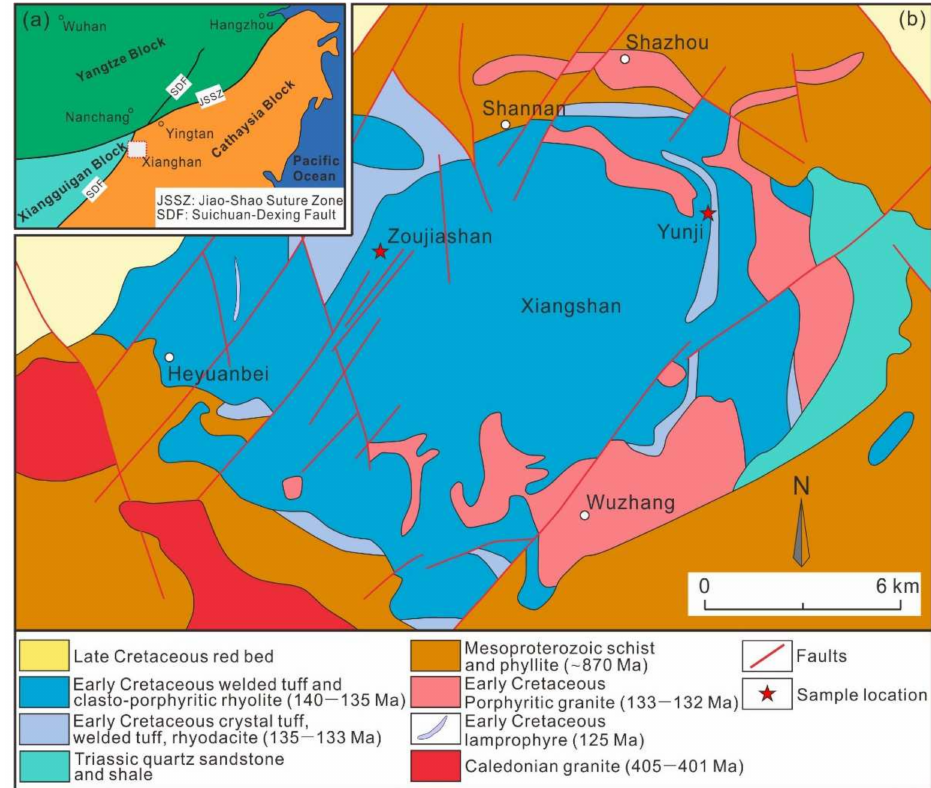
Figure 1. ( a ) Sketched map showing the location of the Xiangshan uranium ore field in South China; ( b ) Simplified geological map of Xiangshan uranium ore field showing the location of Zoujiashan deposit and Yunji deposit investigated in this study (modified after Lin et al.